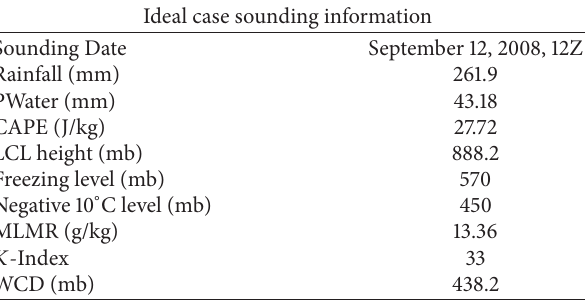
Table 2: Sounding parameter values collected from the Dodge City sounding for the ideal Wichita